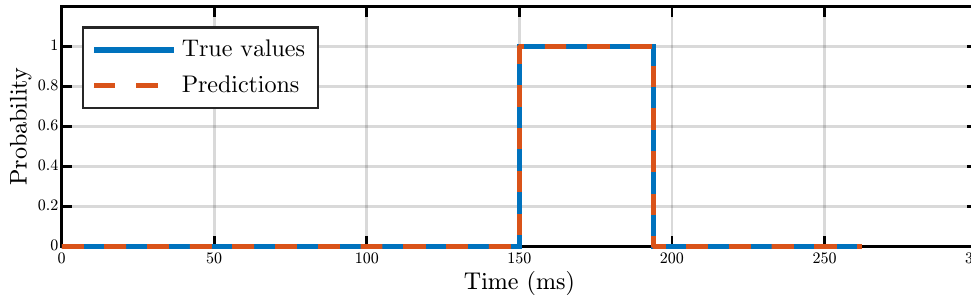
Figure 10. Divertor phase of the test discharge #37270.